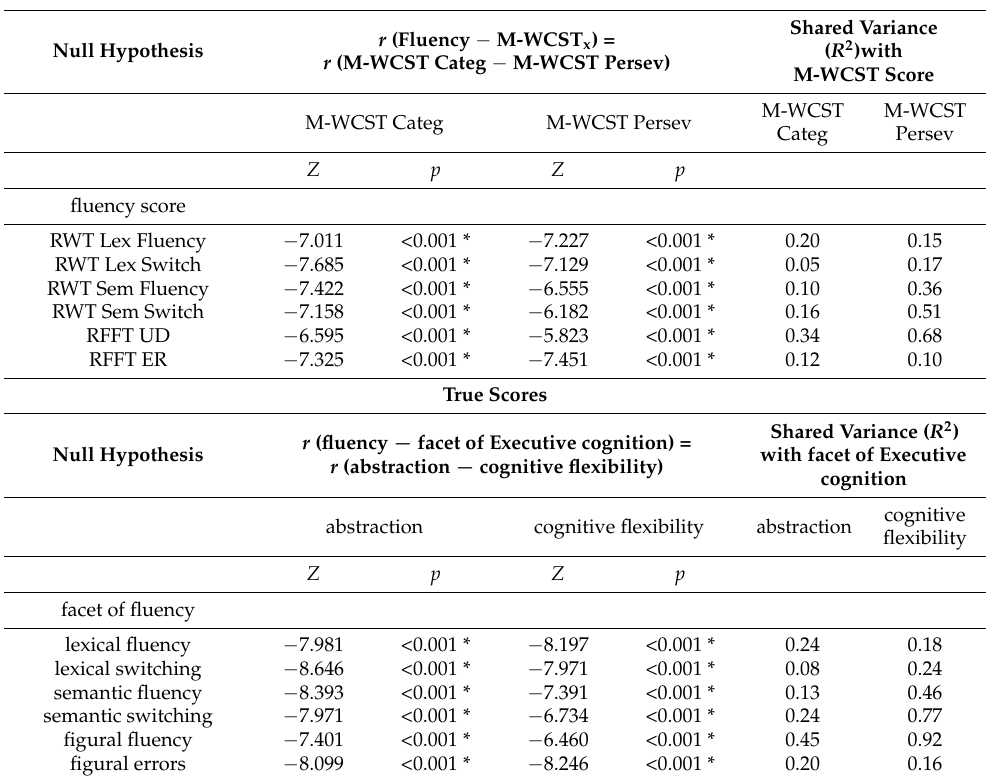
Table 5. Convergent validity of various fluency assessments against M-WCST scores. Observed